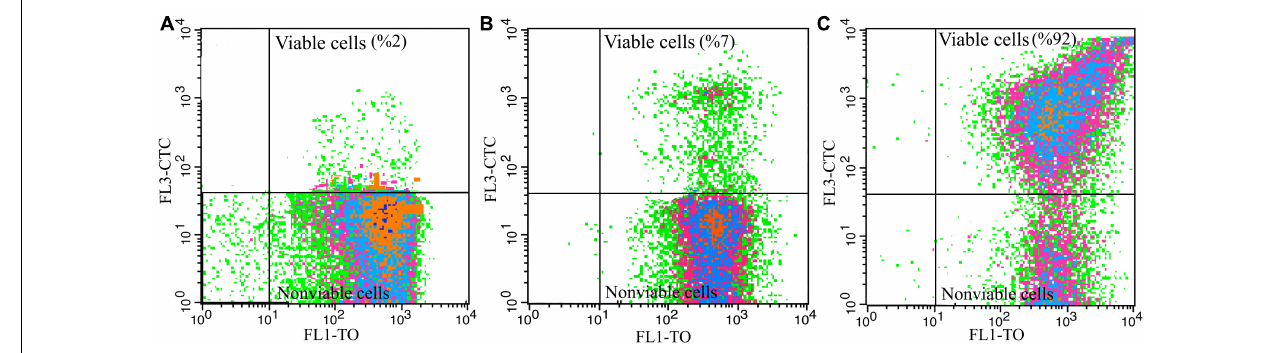
FIGURE 4 | Influence of freeze-drying process on viability of A. senegalensis LMG 23690 T acclimated to different carbon sources. (A–C) Show viability of freeze-dried cells which were already acclimated to EtOH, Glc and GLCAA conditions, respectively. Cells were acclimated to different carbon sources. They were then harvested and underwent a freeze-drying process. Total dehydrogenase activity of freeze-dried cells were determined in a culture medium containing 5% (w/v) ethanol and 1% (w/v) acetic acid using CTC as an indicator.